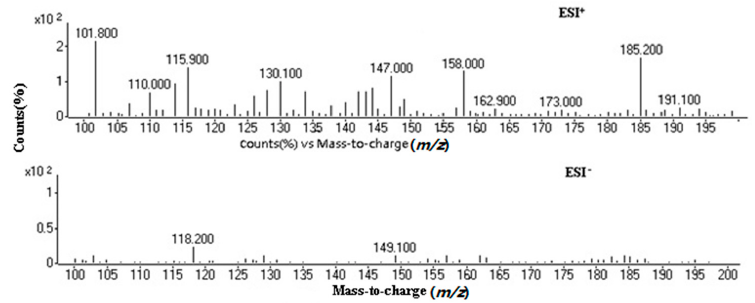
Figure 1. Precursor ions of coumarin in the ESI + /ESI − mode.